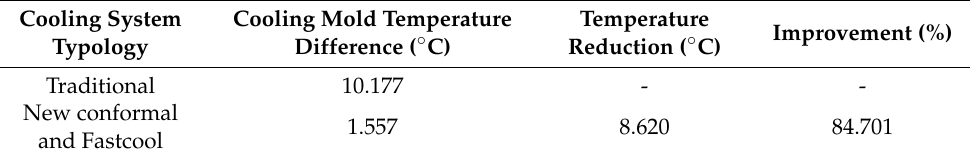
Figure 15. Cooling mold temperature difference (°C). ( A ) New conformal cooling system and Fastcool insert. ( B ) Tradi- tional cooling. Table 9. Cooling mold temperature difference for the analyzed cooling systems.